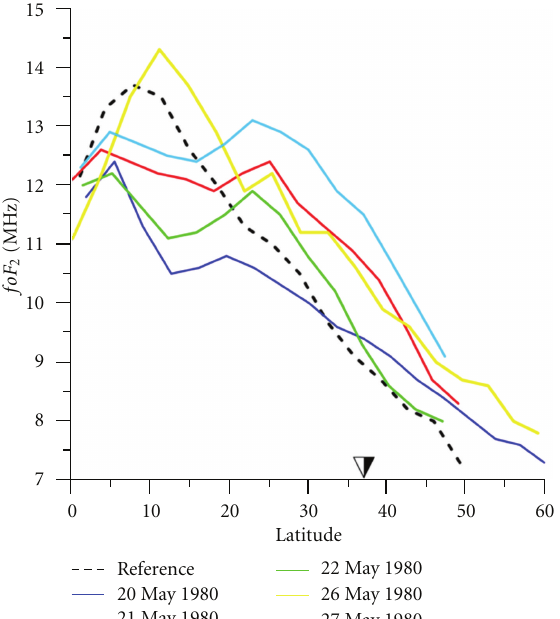
Figure 5: Latitudinal profiles of the critical frequency foF2 close to the epicentral longitude (Intercosmos-19 topside sounder data). Dashed black line: 19 May, color lines: 21–27 May 1980 (see legends in the figure).